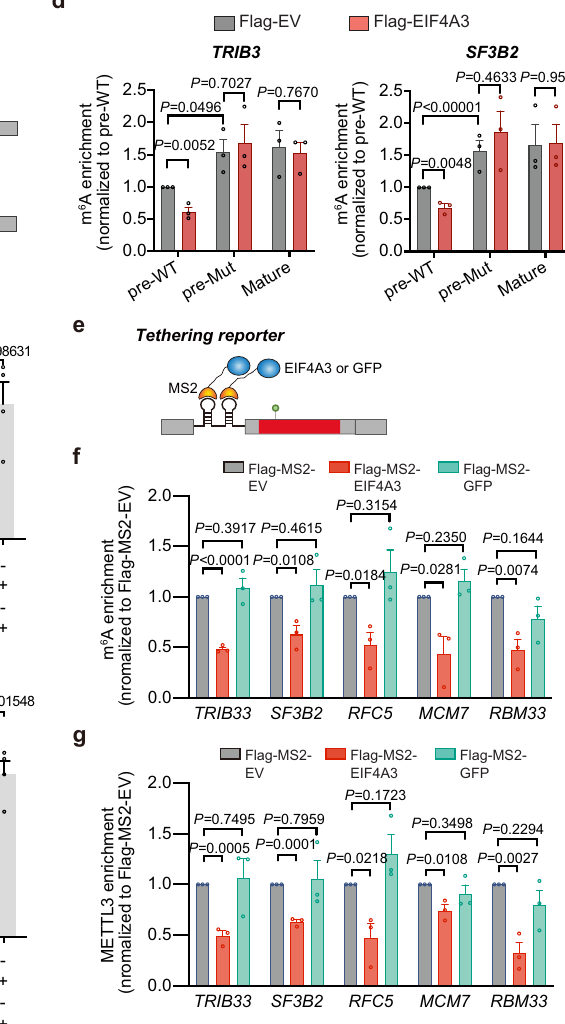
reporter constructs showing m 6 A enrichment in Flag-tagged empty vector and EIF4A3 overexpressed HeLa cells. Data are mean±S.E.M. of three or four inde- pendent experiments. Statistical analyses, two-tailed Student ’ s t -test. e Schematic of tethering reporter construct. f , g meRIP-qPCR ( f ) and CLIP-qPCR ( g ) analysis of tethering reporter constructs showing decreased m 6 A enrichment and METTL3 bindingabilityuponMS2-EIF4A3butnotMS-GFPoverexpression.Dataaremean± S.E.M. ofthree independent experiments. Statistical analyses, two-tailed Student ’ s t-test. Source data are provided as a Source Data fi